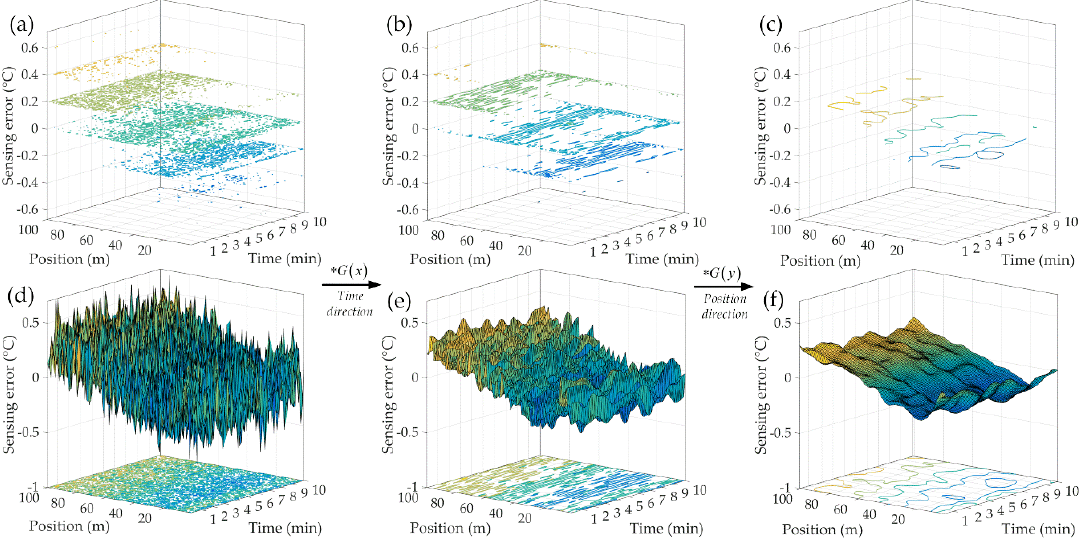
Figure 7. Sensing error contour every 0.2 °C ( a , d ) raw data; ( b , e ) Gaussian convolution along Time direction; ( c , f ) Gaussian convolution along Position direction.